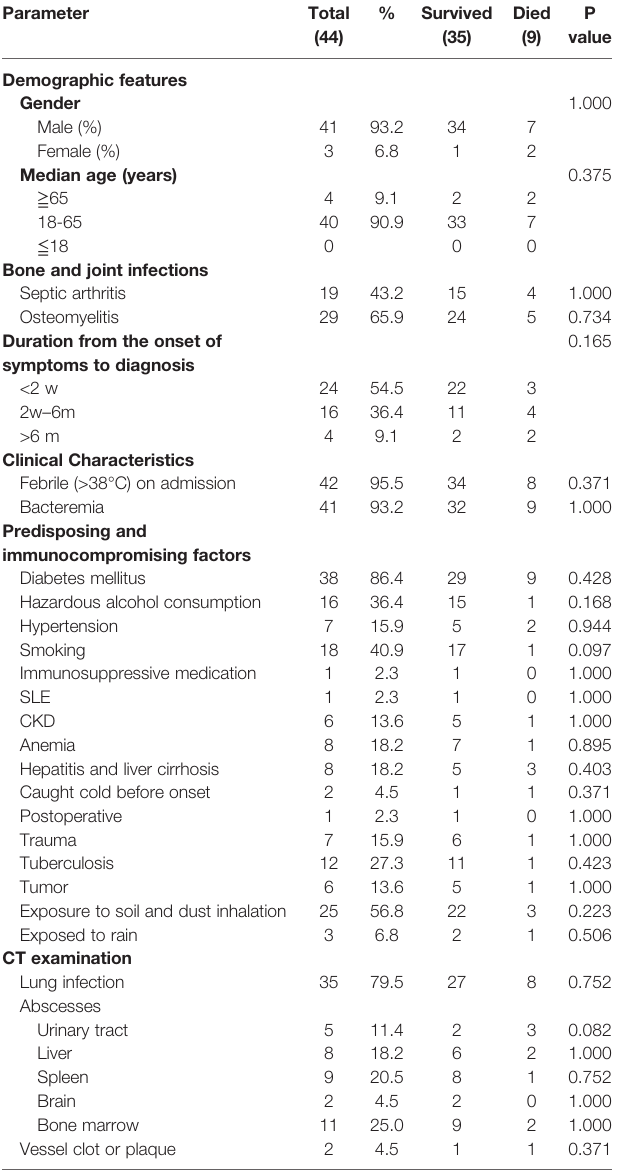
TABLE 1 | Demographic data of 35 survivors and 9 non-survivors having melioidotic osteomyelitis and septic arthritis. Parameter Total (44)